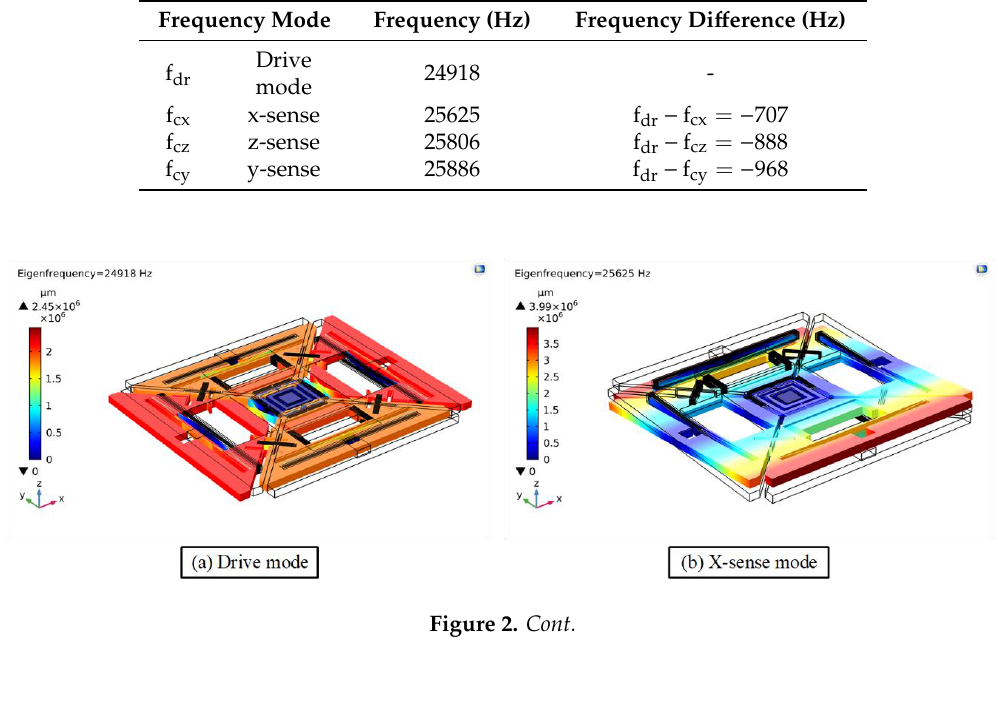
Figure 2. Resonant frequency mode shapes of the proposed single-drive, 3-axis MEMS gyroscope . 3.2. Drive-Mode Analysis A typical MEMS vibratory rate gyroscope consists of a proof mass suspended by elastic beams driven by harmonic oscillations to provide momentum for the Coriolis effect. The drive-mode of a MEMS vibratory gyroscope is a simple one degree of freedom (1-DOF) resonator, which is equivalent to a mass-spring damper system as shown in Figure 3. The drive-mode motion is described by Equation (1), in which the system is excited by a sinusoidal drive force. M d x d ̈ + C d x d ̇ + K d x d = F d sinωt.